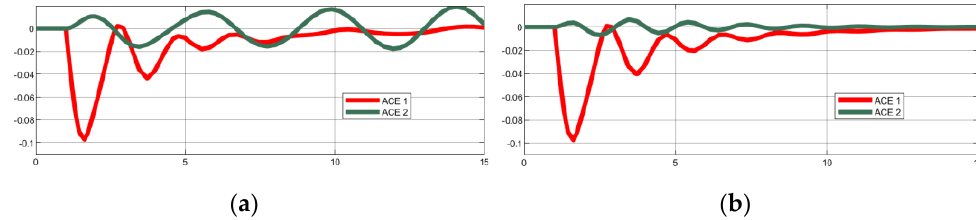
Figure 8. ( a ) ACEs (red: ACE 1, green: ACE2), Case 1. ( b ) ACEs (red: ACE 1, green: ACE2), Case 2.